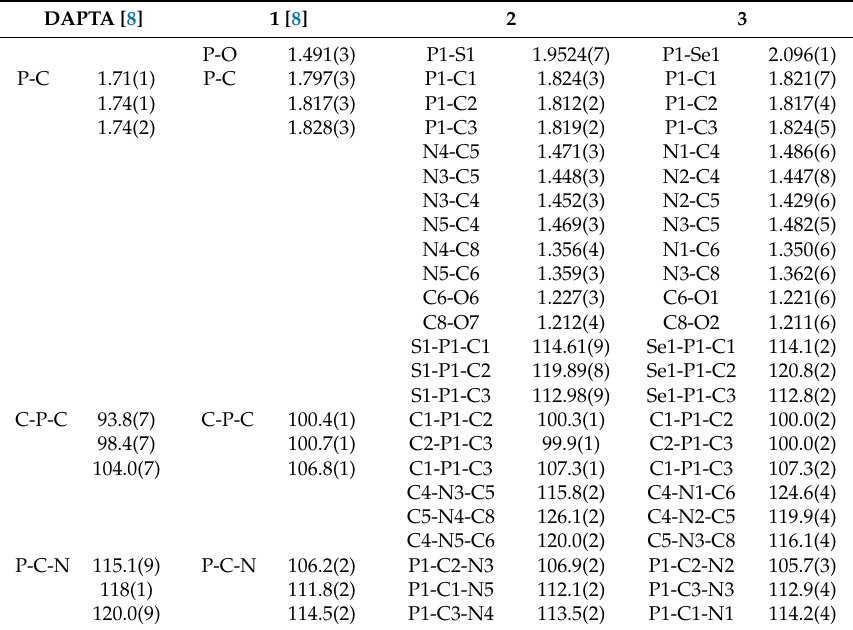
Figure 5. ORTEP diagrams of compounds 2 (left) and 3 (right) with displacement ellipsoids shown at 50% probability level and atom numbering schemes. H-atoms are omitted for clarity. Table 1. Selected bond distances (Å) and angles (°).